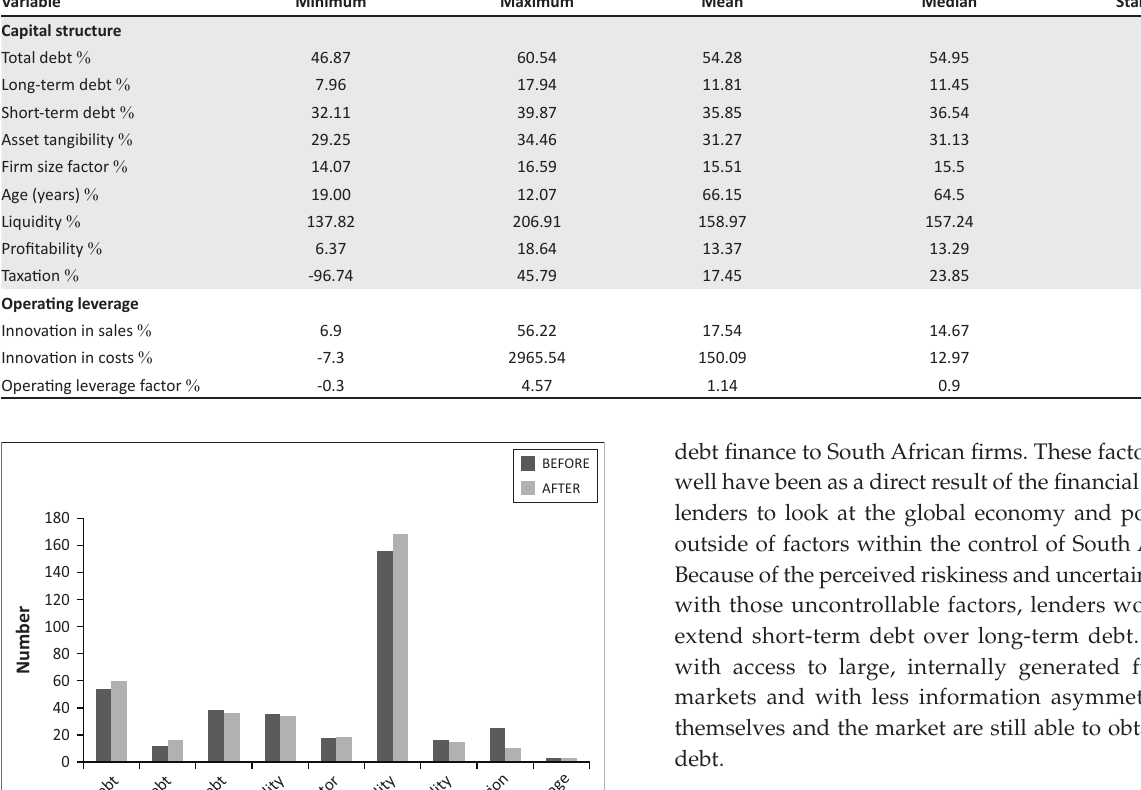
TABLE 4: Total sample level: descriptive summary statistics (1994–2015). Variable